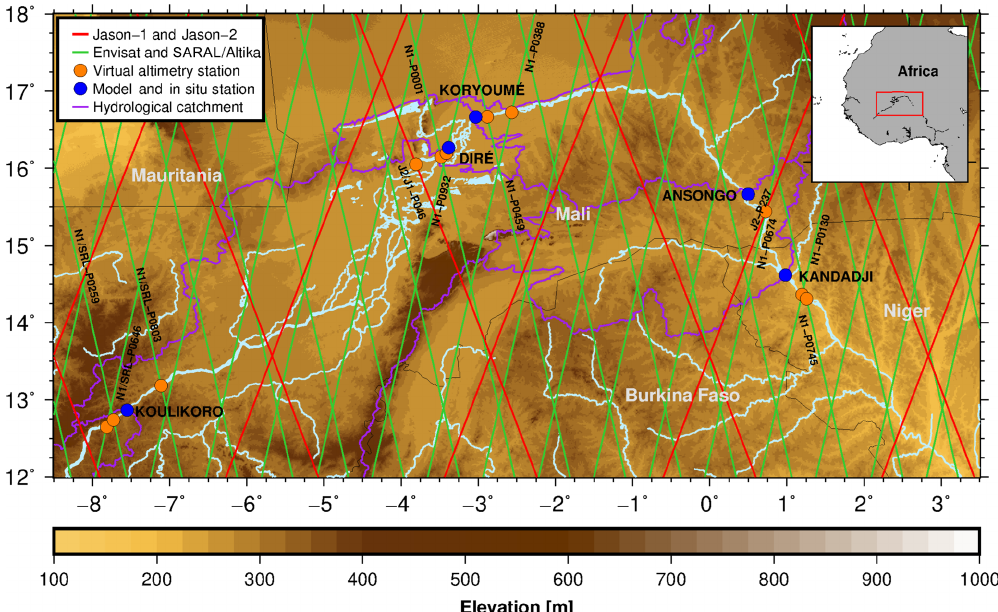
Figure 1. Study area, gauge and virtual gauge locations, altimeter ground tracks, and subbasin delineations (area: Koulikoro – 118400km 2 , Diré – 362000km 2 , Koryoumé – 378800km 2 , Ansongo – 530000km 2 , and Kandadji – 596400km 2